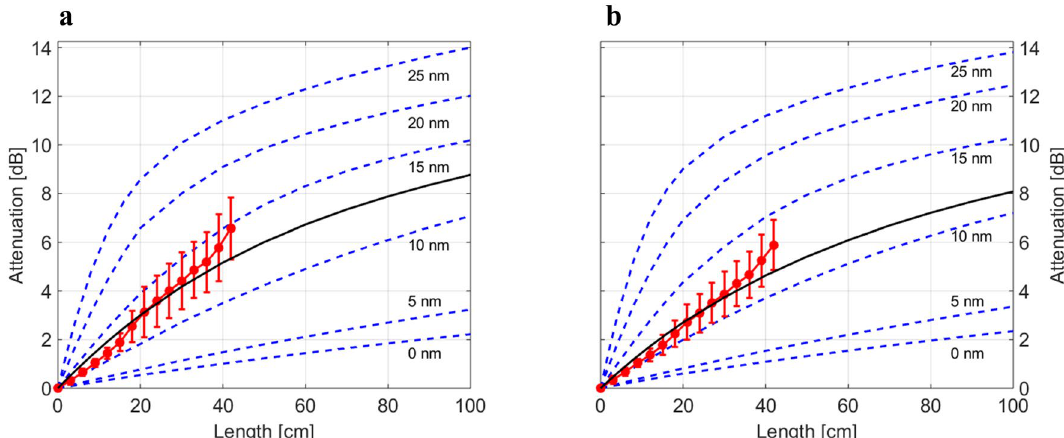
Figure 3. Measured data for the straight fibres (red circles: mean with standard deviation, n = 10) compared to simulation results for various values of the rms roughness of the core-cladding interface S q = [0 … 25] nm (blue dashed lines). The solid black line represents the best interpolation between the simulation for S q = 10 nm and S q = 15 nm based on a least-square fit for the respective fibre: 1143 ( a ), 1144 ( b ).